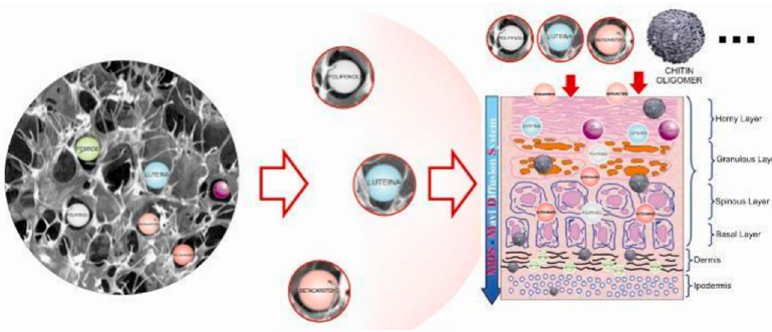
Figure 13. The nanoparticle surface charges influences skin penetration.